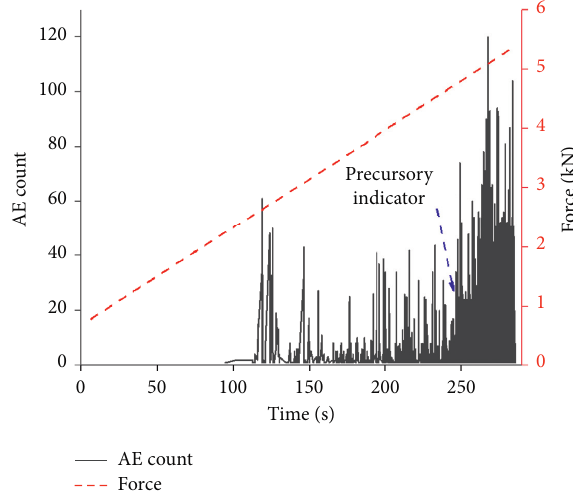
Figure 6: Typical AE count curve with loading time under mode I fracture.